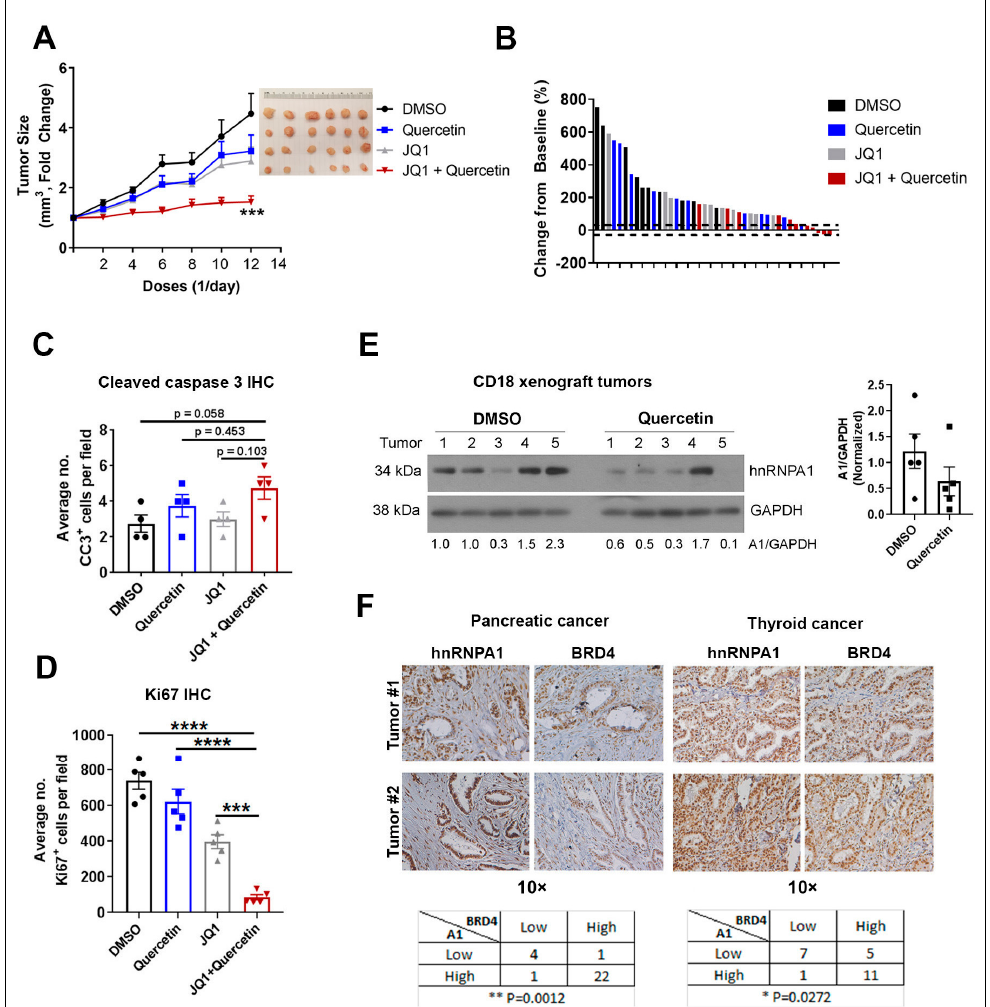
Figure 6. Quercetin increases the anti-tumor effects of JQ1 in vivo. CD18 pancreatic cancer cells (1.5 × 10 6 ) were subcutaneously injected into the flanks of nude mice and allowed to form tumors for 2 weeks. Mice with established tumors were randomized and treated intraperitoneally with DMSO, JQ1 (50 mg/kg), Quercetin (40 mg/kg), or a combination of JQ1 (50 mg/kg) and Quercetin (40 mg/kg) daily Mon–Fri for 3 weeks. ( A ) Tumor growth was assessed daily Mon–Fri, and tumor volume calculated and normalized to tumor volume at the start of treatment. ***, p < 0.001 compared to the DMSO-treated group. Error bars represent SEM from at least 10 individual tumors. ( B ) Waterfall plot was generated to demonstrate change in tumor volume relative to start of treatment. Dotted lines